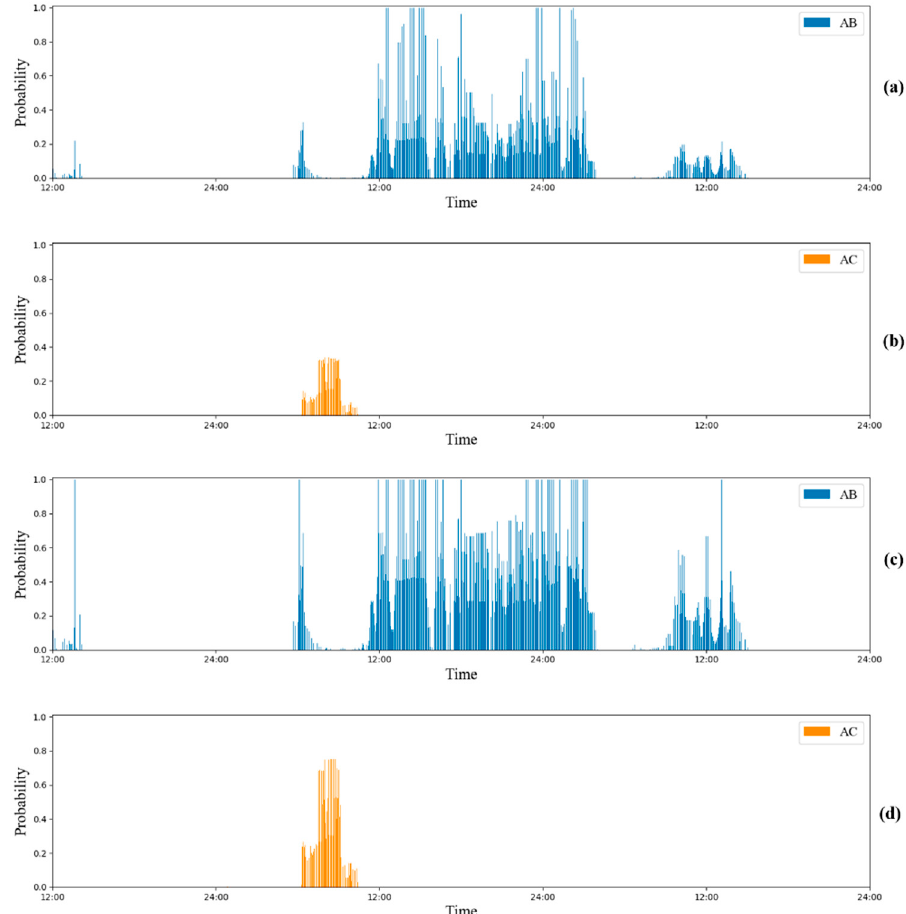
Figure 6. The probability histograms of AB and AC zebras over a 60-h period: ( a ) A–B and ( b ) A–C from the model with DDC; ( c ) A–B and ( d ) A–C from the model without DDC.